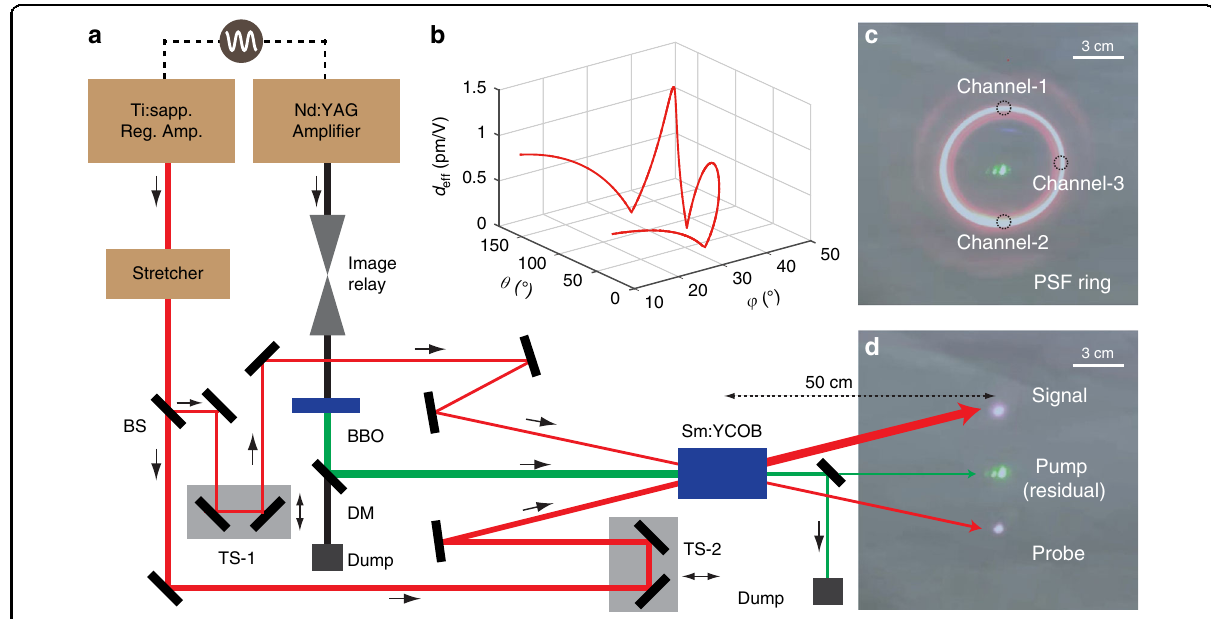
Fig. 2 System layout and beam photograph. a Single-stage QPCPA setup with a Sm:YCOB crystal and two electrically synchronized lasers. In addition to the pump and signal, a weak probe at 810 nm is also introduced to measure the small-signal gain. BS beam splitter, DM dichroic mirror, TS translation stage. b Effective nonlinear coef fi cient d eff of the Sm:YCOB crystal in the phase-matching plane ( θ , φ ). c PSF ring without a signal seed. Channel 1 for signal ampli fi cation; Channel 2 for probing the small-signal gain; Channel 3 for detecting the PSF energy. These three channels are on the same ring of 810-nm wavelength and have an equal aperture of 0.4 cm. d Signal and probe beam spots with a strong signal seed